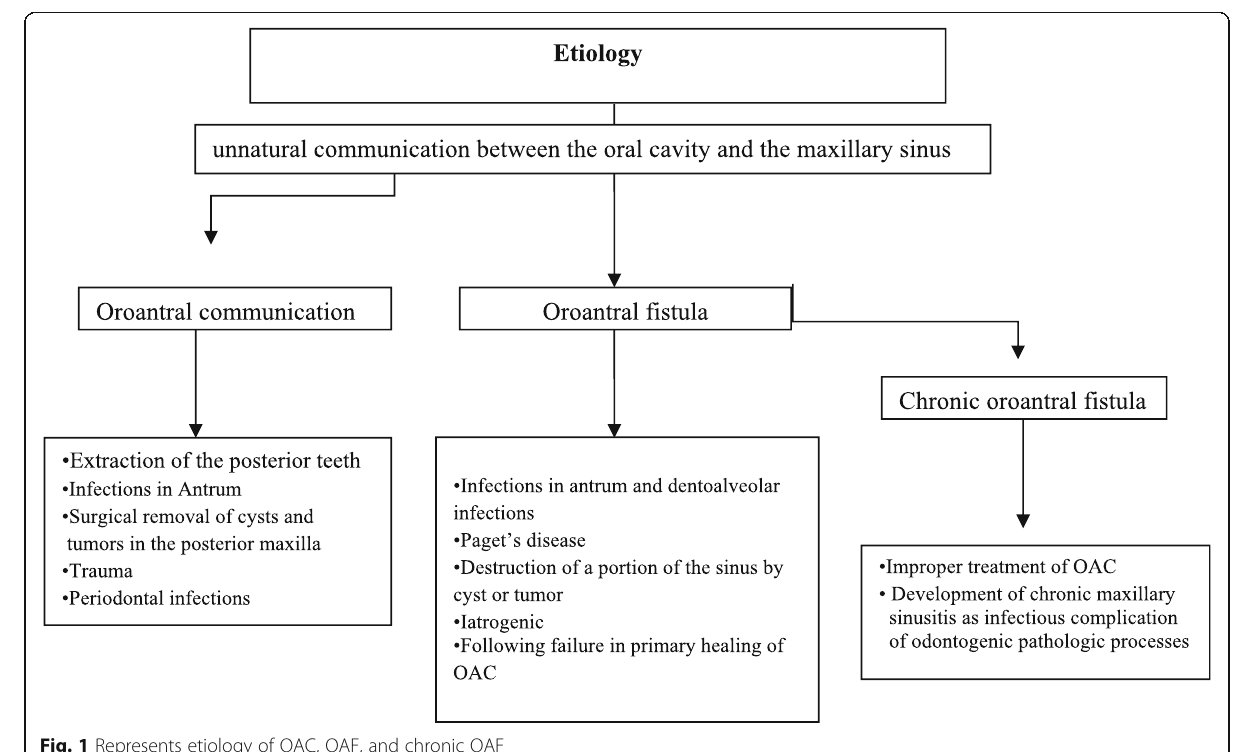
Fig. 1 Represents etiology of OAC, OAF, and chronic